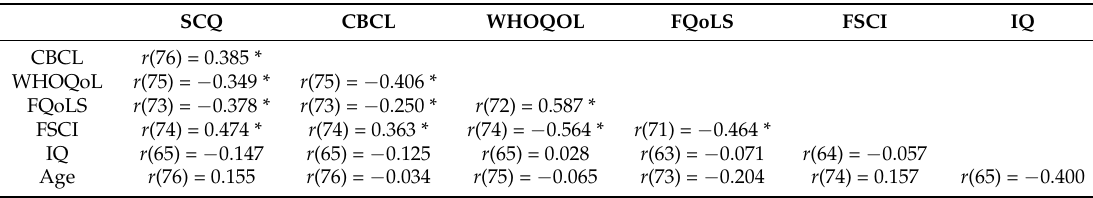
Table 2. Correlations between study variables.